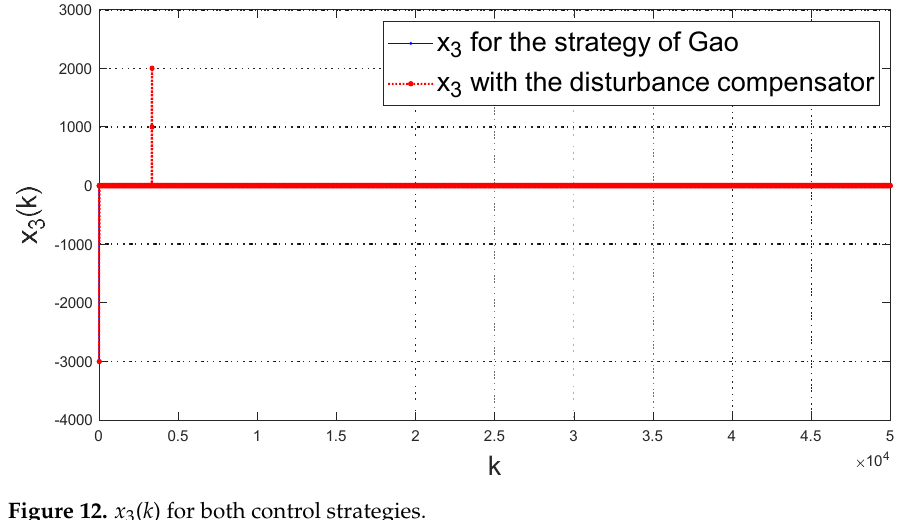
Figure 12. x 3 ( k ) for both control strategies.